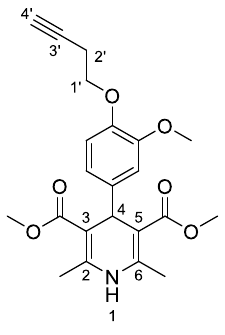
Figure 14. Chemical stucture of 3m .